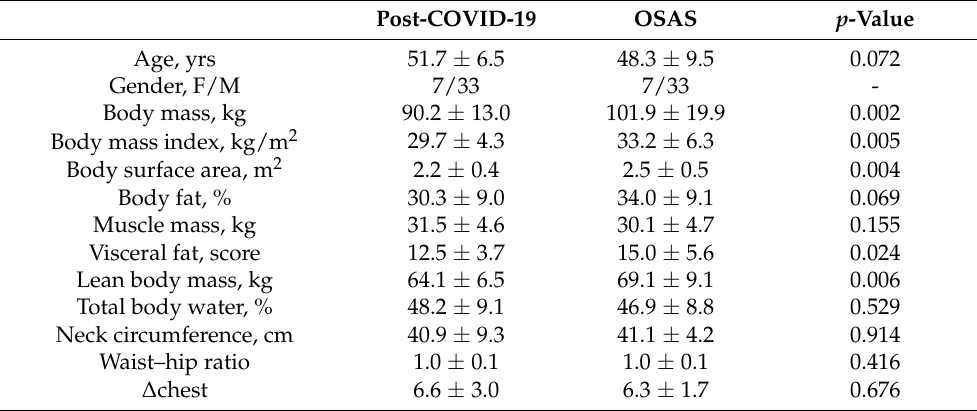
Table 1. Participants’ characteristics. Data are expressed as mean ± standard